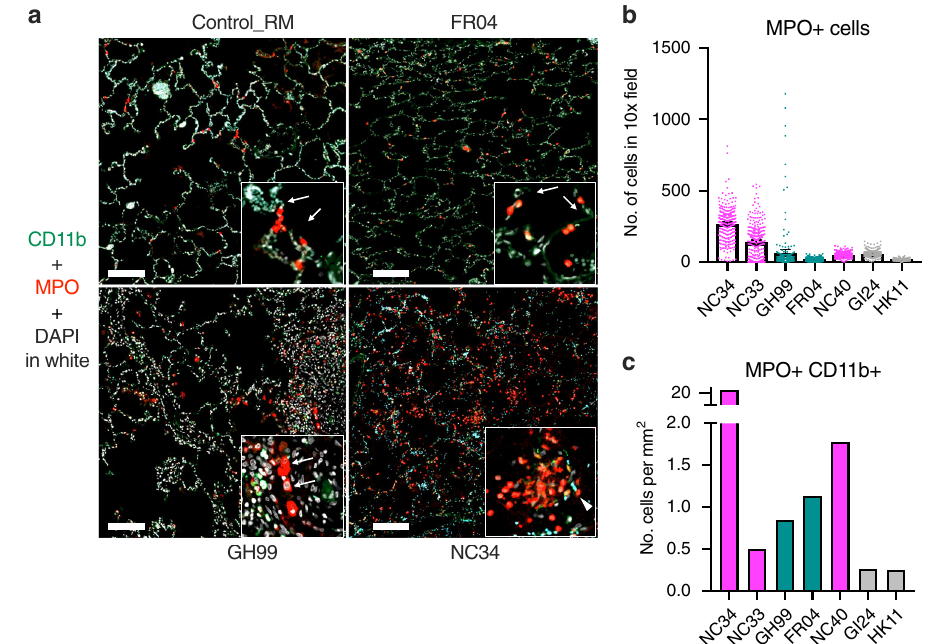
Fig. 4 CD11b + neutrophils accumulate in the lung of infected animals with severe disease. a Fluorescent immunohistochemistry in the lung of AGM and RM showing in fi ltration of MPO + neutrophils and MPO + CD11b + neutrophils. MPO and CD11b staining. White: DAPI (nuclei); green: CD11b; red: MPO. The number of MPO positive cells (red, arrows) increases in proportion to the severity of pulmonary disease from rare in the control (HK11), to mild in FR04, moderate in GH99 and severe in NC34. Dual positive MPO + CD11b + positive cells (arrowheads) are present in the most severely affected animals (NC34). b Mean and number of MPO + cells, each dot is one count the standard deviation represents variability in the number of positive cells/area and c and MPO + CD11b + per mm 2 in lung